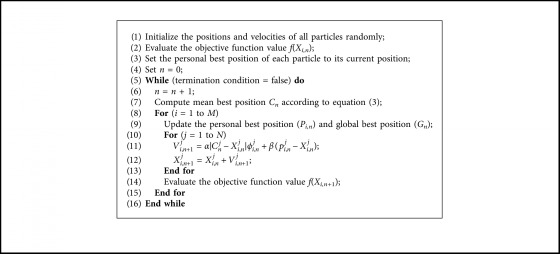
Pseudocode of RDPSO.